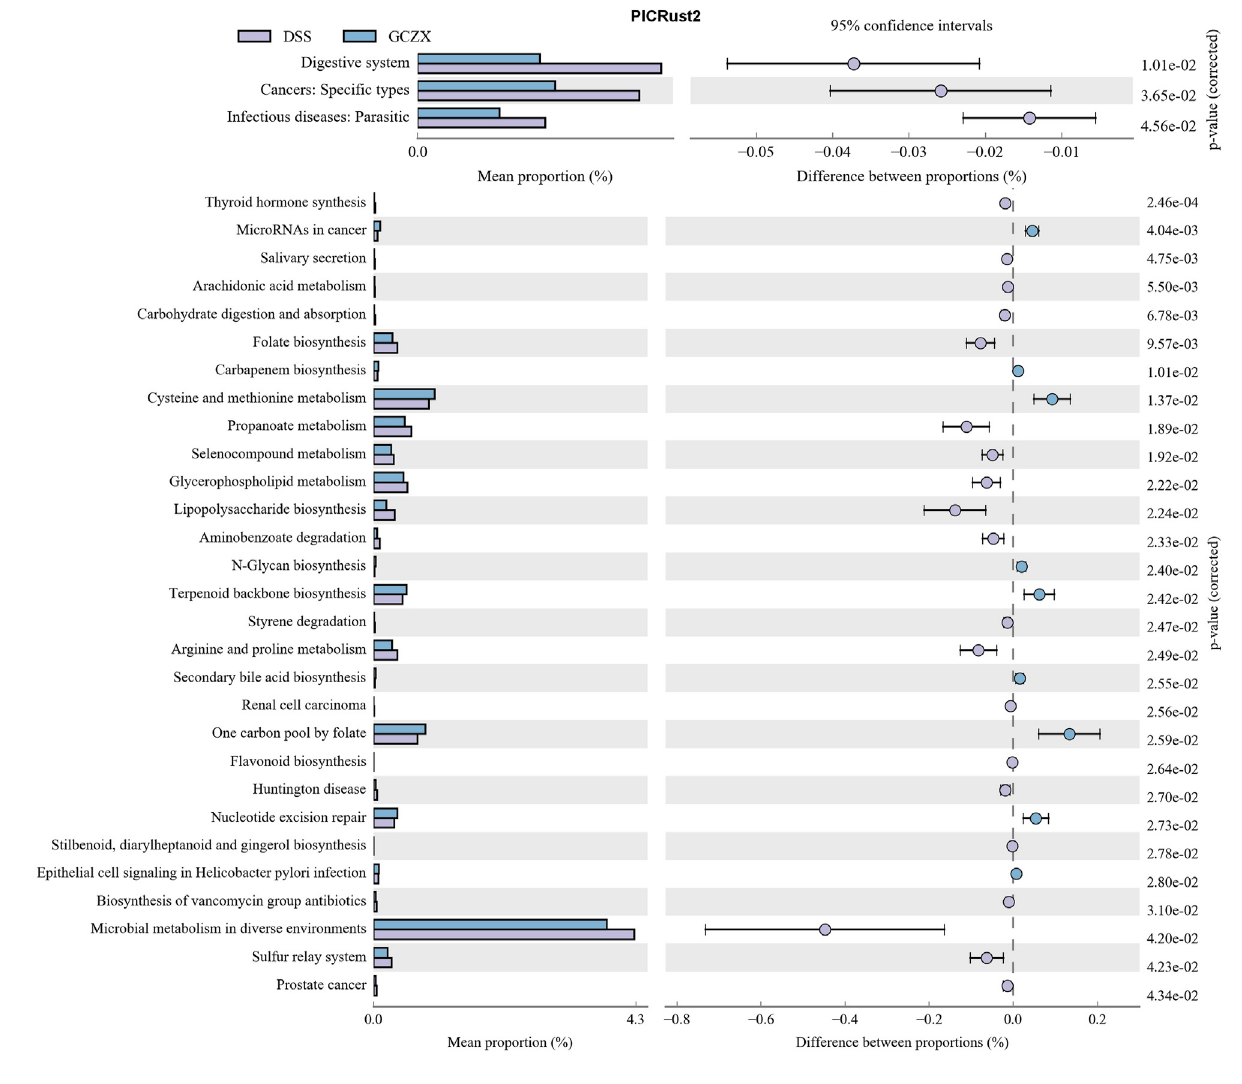
FIGURE 7 | PICRust2 analysis of the therapeutic role of GCZX